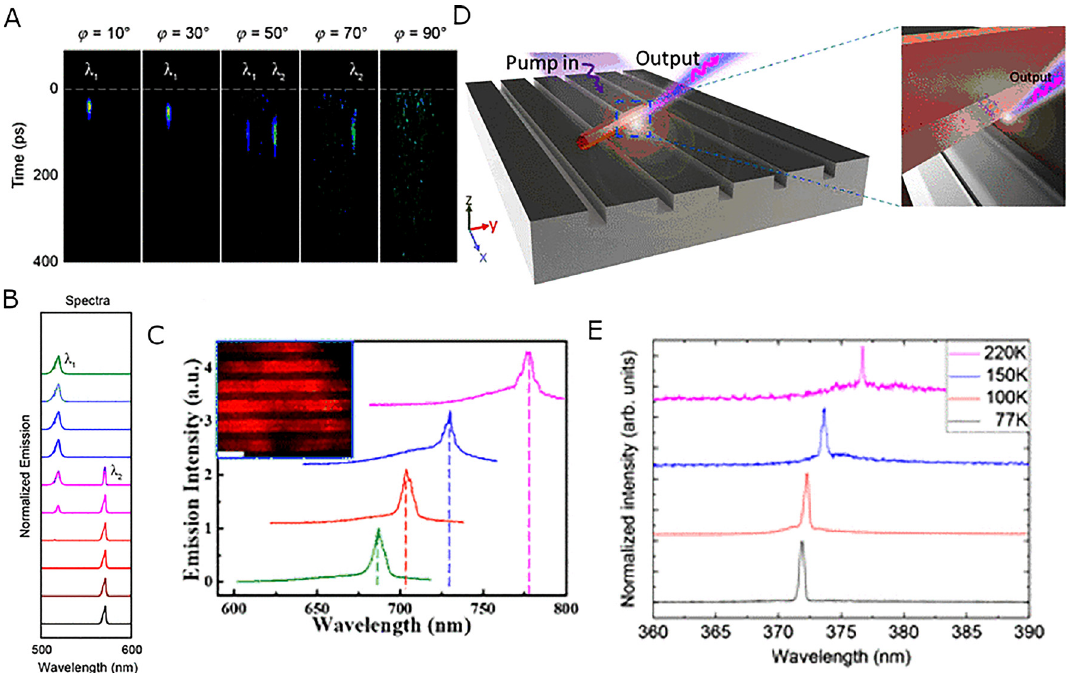
Figure 9: Tuning peak wavelength of emission. (A)Experimentalstreakcameraimagesofnanolaserarrayasthein-planepumppolarizationisaltered.(B)Numericalsimulationofthespectra for varying pumppolarization. (A) and (B) Adapted and reprintedfrom a study by Knudsonet al. [74] with permission.(C) Spectraof nanolaser array as sample is annealed. A blue-shift in the peak wavelength occurs; Inset: Fluorescent microscope image of nanolaser array. Reprinted from a study by Huang et al. [77] with permission. (D) Schematic of pseudowedge nanolaser array with ZnO nanowire placed on top of Ag grating. (E) Varshni red-shift of emission wavelength as ambient temperature is increased. (D) and (E) adapted and reprinted from a study by Chou et al.